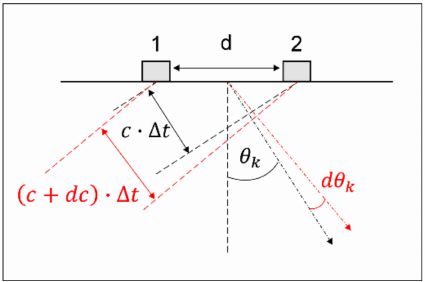
Figure 2. Beam steering error d θ k due to sound velocity variation dc . 1,2—transducer elements. d—fixed element